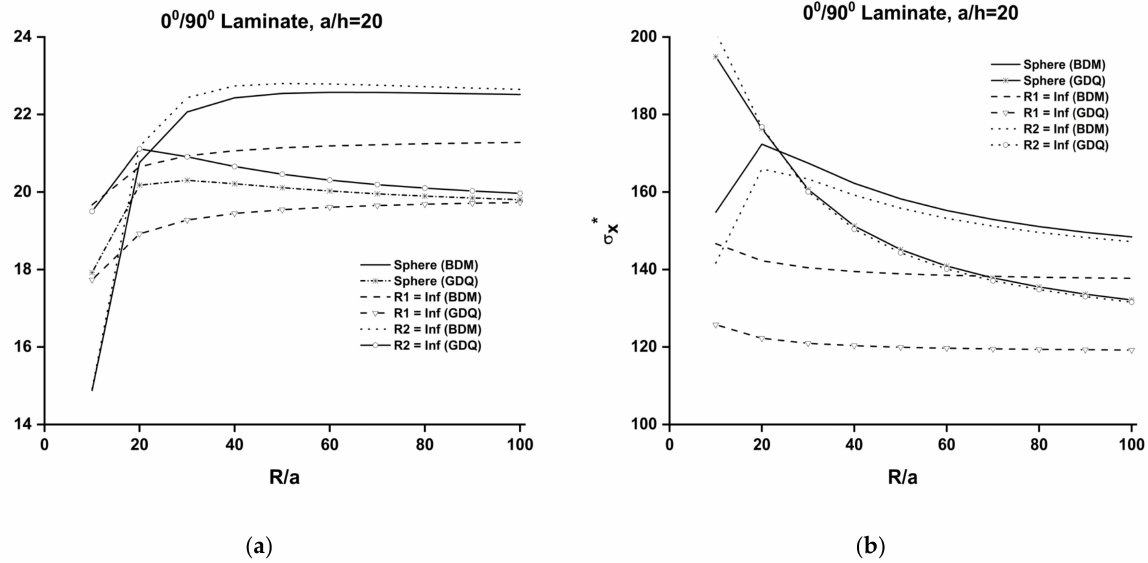
Figure 5. ( a ) Variation of non-dimensional displacement, w ∗ , and ( b ) non-dimensional stresses, σ x ∗ , of moderately thick ( a / h = 20) curved panels (one spherical and two cylindrical) with an R/ a ratio for antisymmetric [0 ◦ /90 ◦ ]